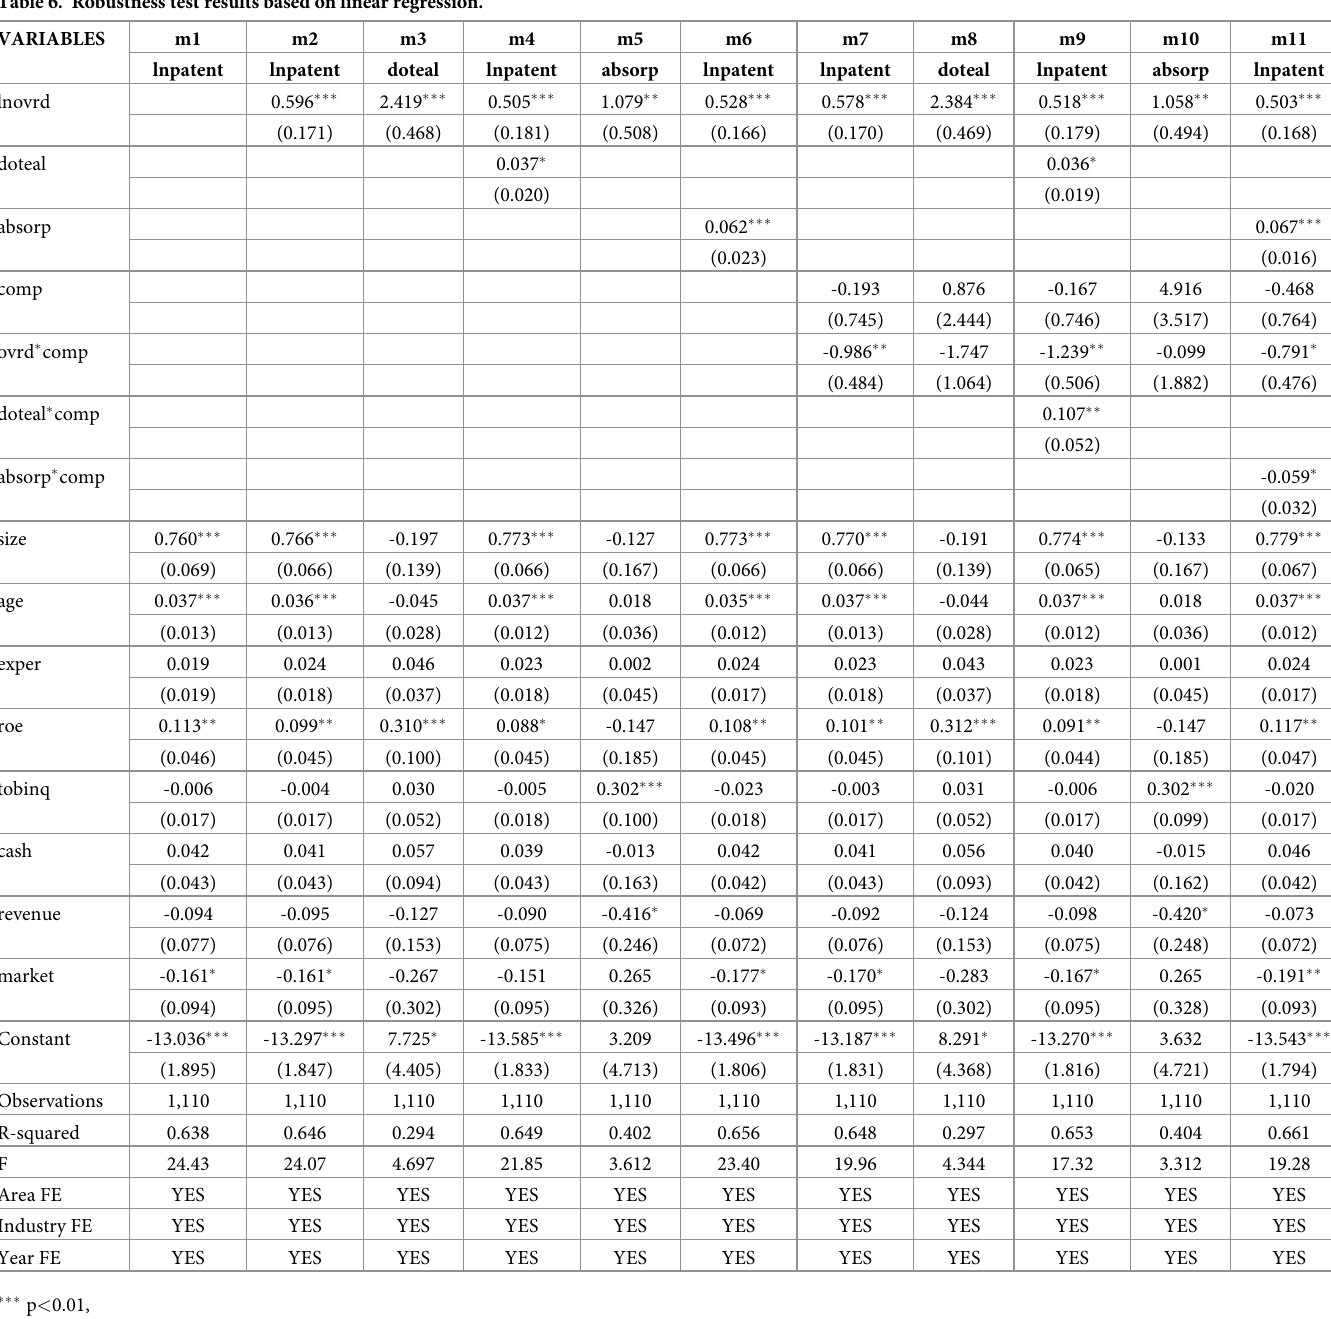
Table 6. Robustness test results based on linear